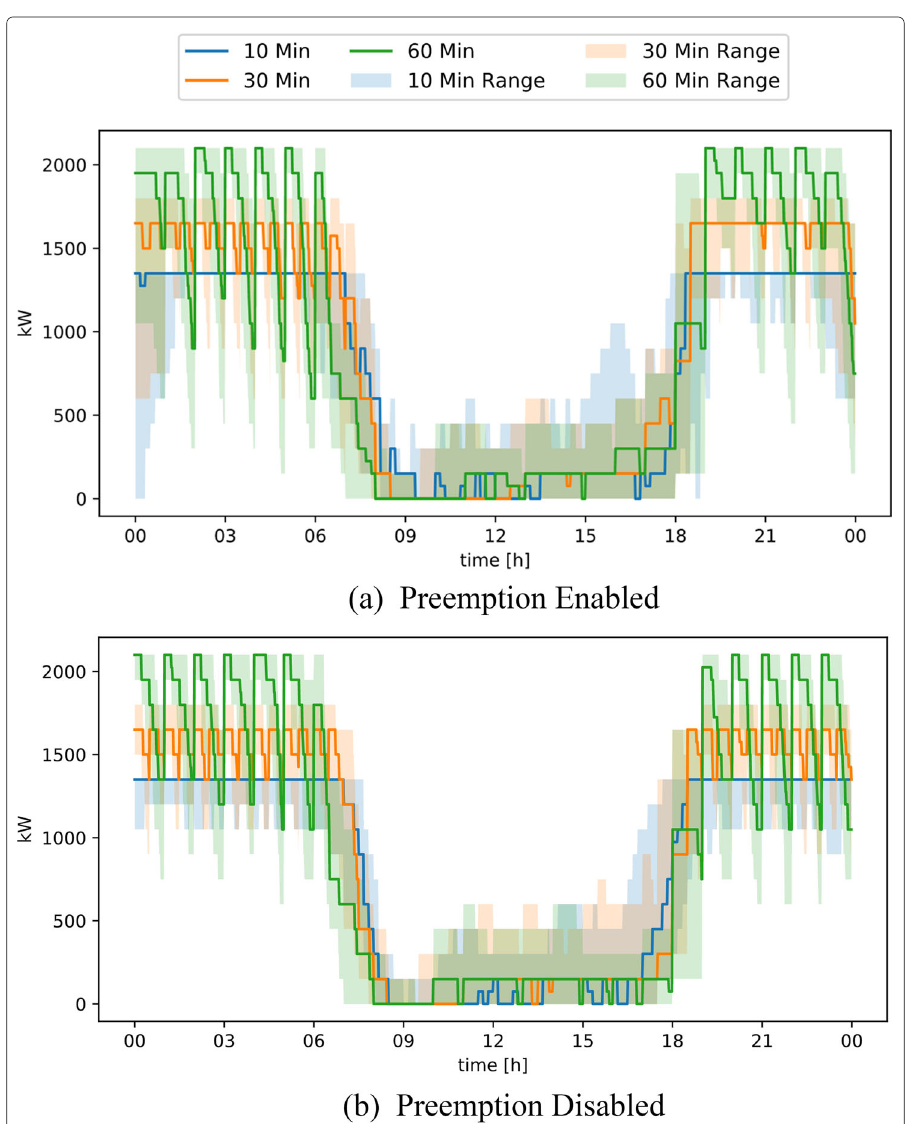
Fig. 4 Resulting Load Profiles at Different Time Granularities — 10, 30, 60 min. Solid line — median; fill — range